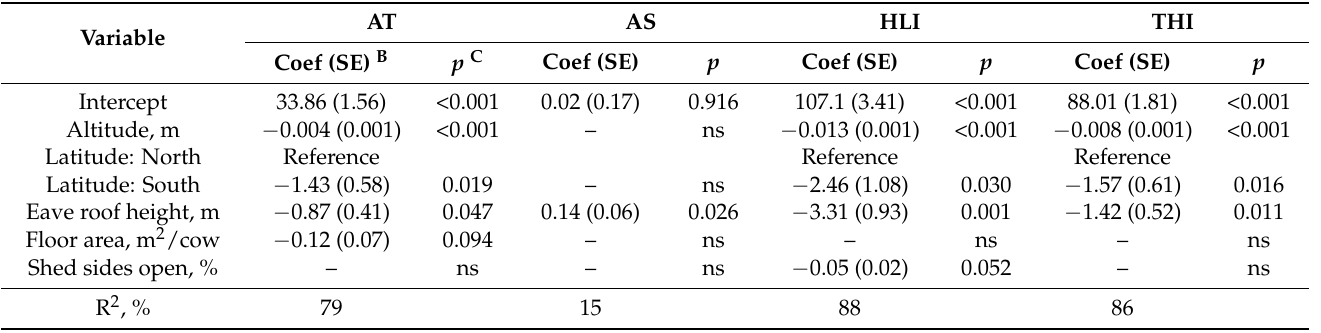
Table 6. Multivariate models identifying the factors associated with the temperature (AT, ◦ C), humidity (RH, %), air speed (AS, m/s), heat load index (HLI) and temperature-humidity index (THI) inside the cowsheds A .